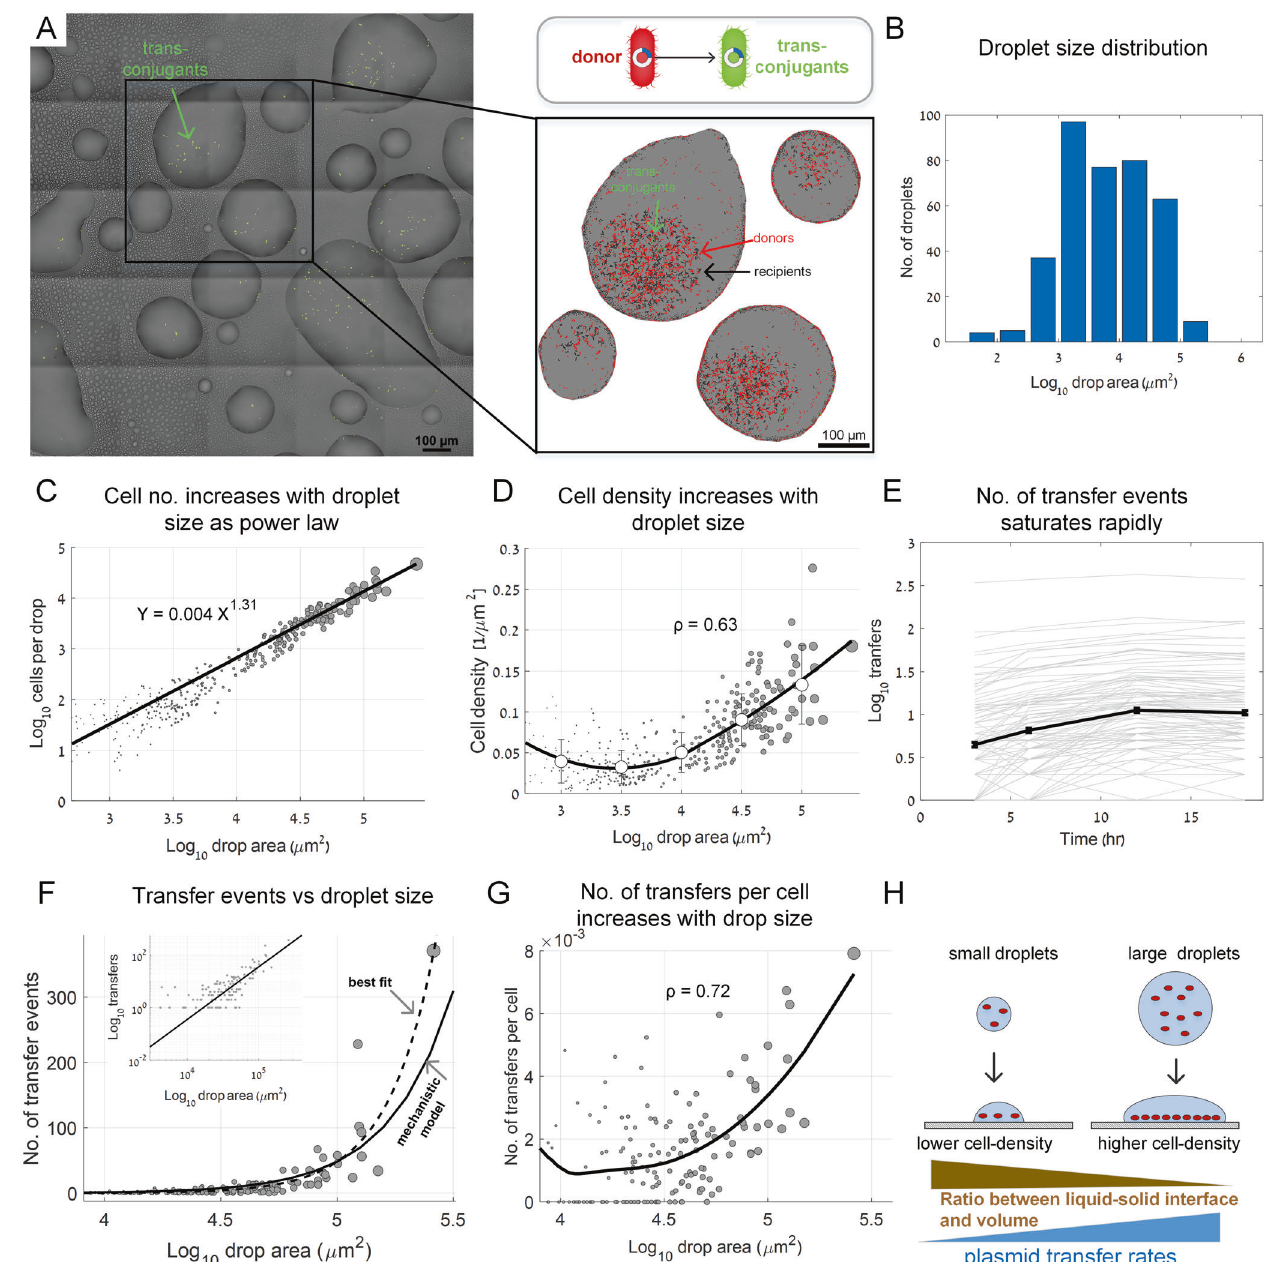
Fig. 1 Droplet size effect on plasmid transfer rates. A A representative section of the glass surface covered by sprayed droplets at 6 h after spraying. Green cells are trans-conjugants. Inset: zooming into individual droplets. Donor, recipient, and trans-conjugant cells are shown in red, black, and green respectively. B Droplet area histogram ( ‘ area ’ refers to the area of the liquid <> solid interface, A ). C The total number of cells ( N ) in individual droplets (including donors, recipients, and trans-conjugates at t = 6 h). Circle size re fl ects droplet area. Axis plotted in log-log scale (dataset includes 372 droplets). D Surface cell density in individual droplets. Line shows smoothed average (using LOESS), circles represent mean ± STD for binned data. ρ represents Spearman rank correlation coef fi cients ( P < 10e-10). E Lines show cumulative number of transfer events over time in individual droplets at 3, 6, 12, and 18 h post inoculation (semi-log scale). Solid black line represents mean ± SE (SE smaller than symbols). F Number of transfer events as a function of droplet area: Circles are experimental data. Black line: mechanistic model = 3.58·10 − 7 · A 1.62 (SI). Dashed line: best- fi tted line based on data T = 1.08·10 − 9 · A 2.12 ( fi tted as a power law, SI). Inset: same data, but at log- T e e log scale. G Transfer events per cell ( T c ) as a function of droplet area. Black line is smoothed data (LOESS). ρ represents Spearman rank correlation coef fi cients ( P < 10e-10). H Conceptual representation of the underlying mechanisms explaining the increase in plasmid transfers as a function of droplet area. In ( F ) and ( G ), droplets are shown only for A > 10 3.9 µm 2 (smaller droplets show mostly zero transfers). few hours post inoculation. At 6 h, there were already dozens of in larger droplets would result in a higher number of transfers per transfer events in the larger droplets (Fig. 1A, E), the majority cell ( T c ). occurring within 6 – 12 h, peaking at 12 h (Fig. 1E), corroborating We fi rst tracked the number of transfer events ( T e ) within other studies [10, 16, 17]. The data indicate that the accumulated individual droplets. Trans-conjugates were observed as early as a